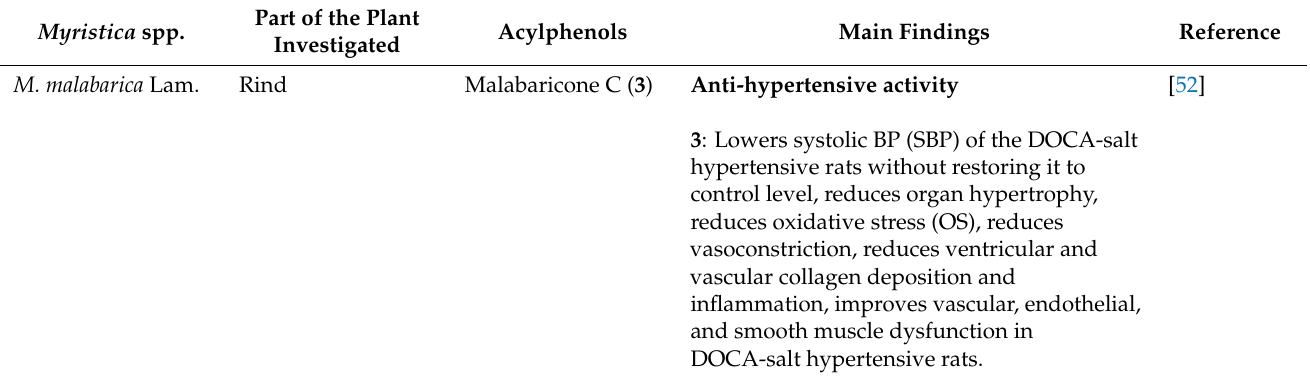
Table 11. The antihypertensive activity of acylphenols from the genus Myristica . Myristica